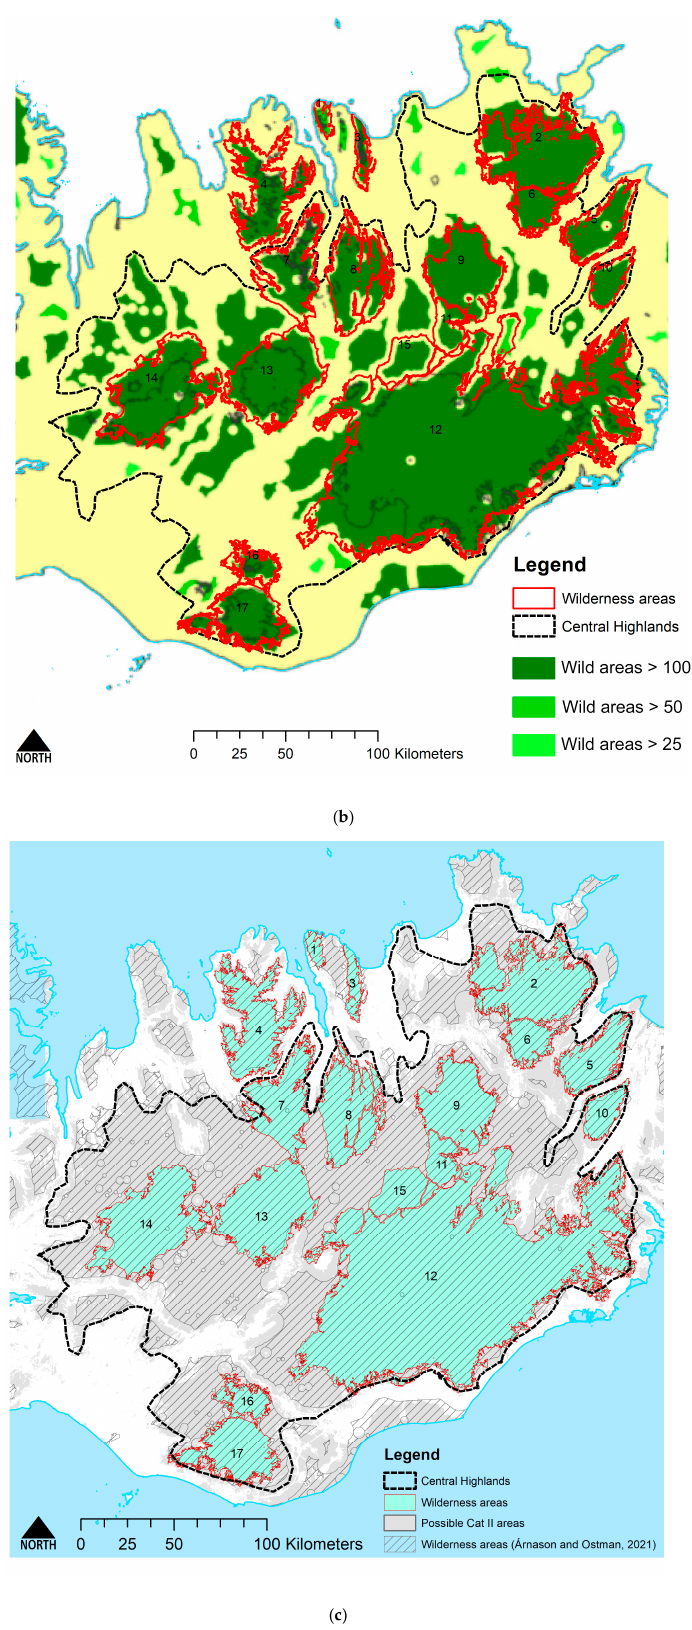
Figure 13. Comparison with wilderness maps from: ( a ) Kuiters et al. (2013), ( b ) Ólafsdóttir and Runnström (2011), and ( c ) Ostman et al. (2021) .